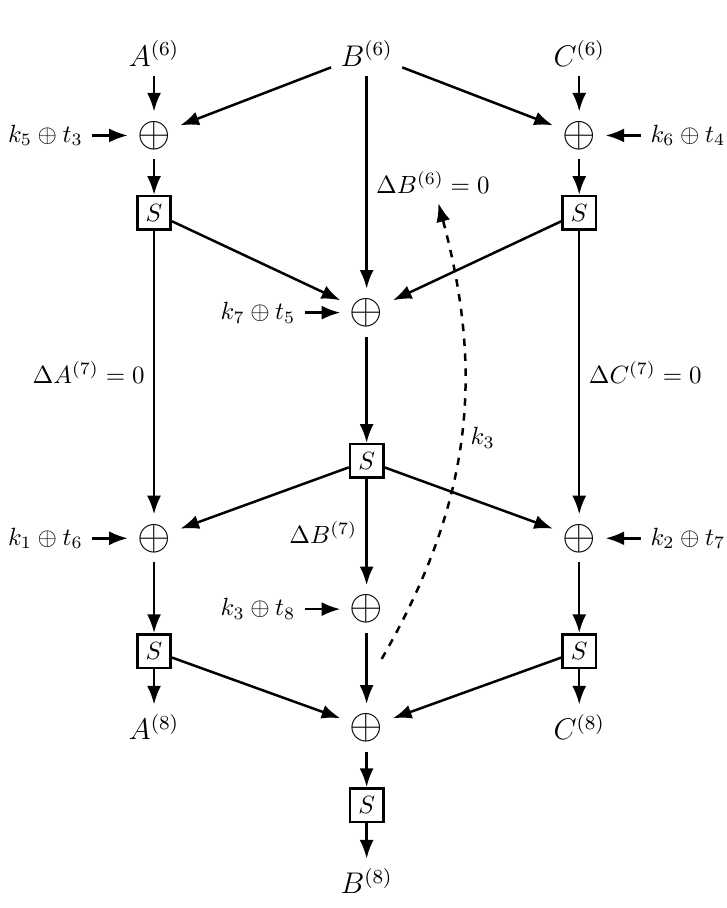
Figure 3: The last two rounds in the attack on eight-round